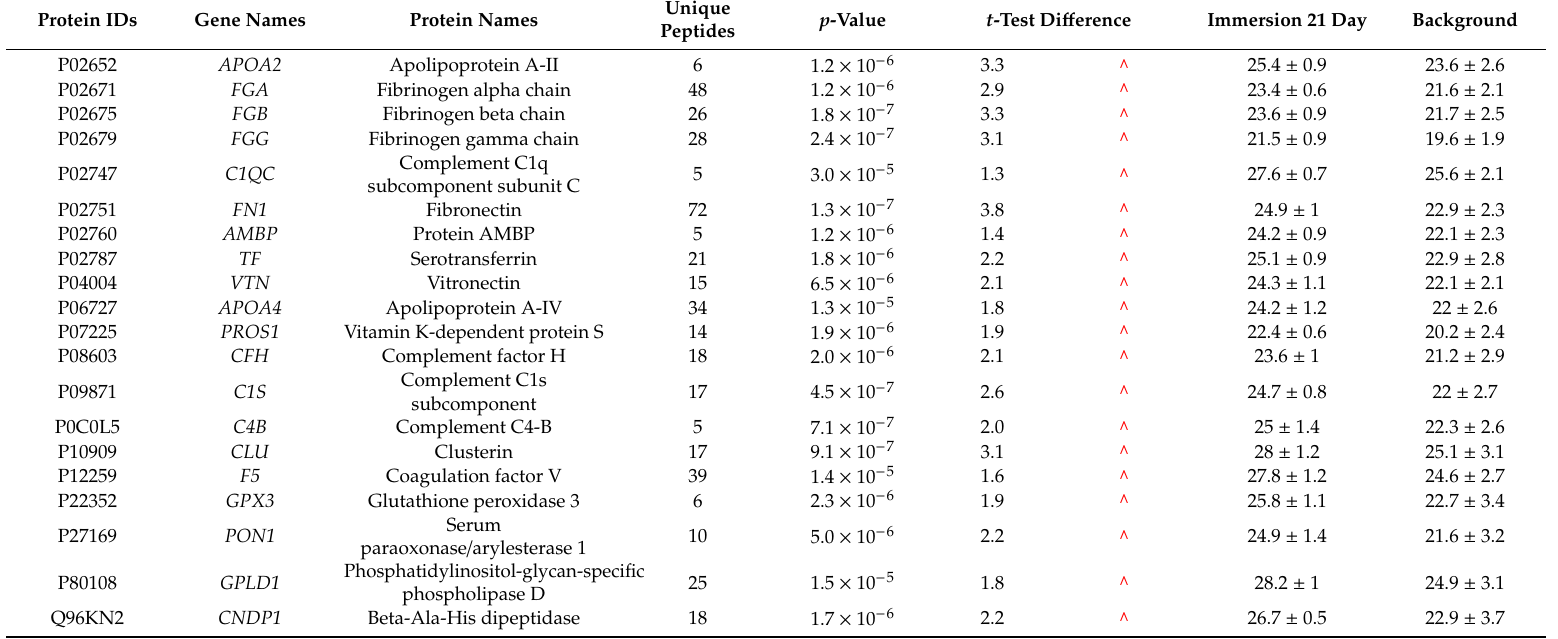
Table 1. The list of proteins significantly changed ( p < 0.01) on the 21st day of the head-down bed rest (HDBR) ground-based experiment with respect to their background levels (the day before the experiment). Proteins were identified by pair-wise comparison (Welch’s t -test). Red/blue symbol—the increase/decrease of the protein level with respect to the background.